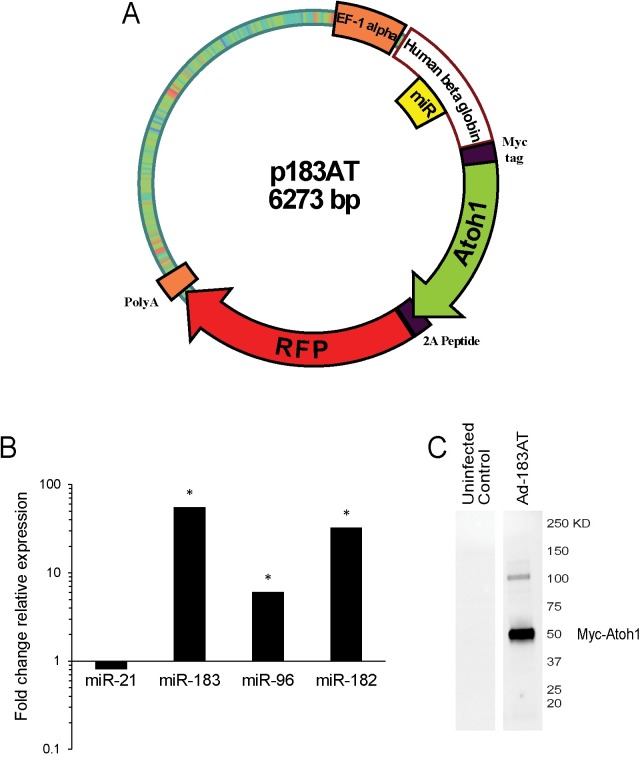
Expression vector design and validation.(A) Schematic diagram of the parent expression vector p183AT for combined production of miR-183 family members (miR), Atoh1 transcription factor, and red fluorescent protein (RFP). The primary transcript is produced from an EF-1 alpha promoter, the miRNAs are processed from a human beta globin intron, and Atoh1 and RFP are separately produced by picornaviral 2A peptide “cleavage”. (B) qRT-PCR validation of miR-183 family member expression in HEK 293 cells. Shown is fold change in expression of miR-21, miR-183, miR-96, and miR-182 in total RNA from Ad-183T infected cells relative to Ad-T. miRNA detection levels were normalized to U6 snRNA. Asterisks indicate statistically significant differences (p<0.05) determined using a two-tailed, type 2 Student’s t-test (n = 3). (C) Western blot analysis of lysates from uninfected control and Ad-183AT infected HEK293 cells showing Myc-tagged Atoh1 detection at the approximate expected size of 43 KDa.